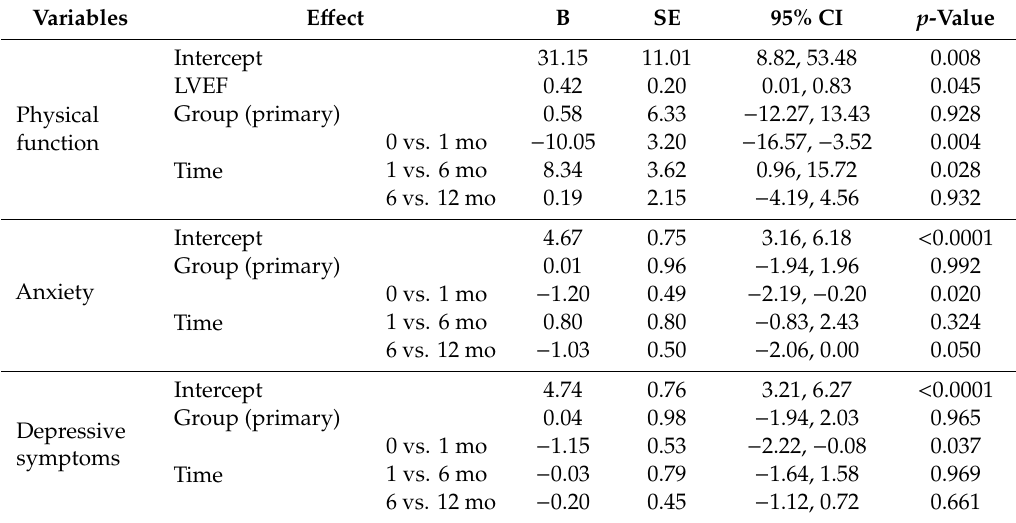
Table 4. Mixed Modeling Procedures: Group-by-Time E ff ects on Pre-Implant-to 1, 6, and 12 months Post-Implant Changes in Physical Function and Psychological Distress of Defibrillator